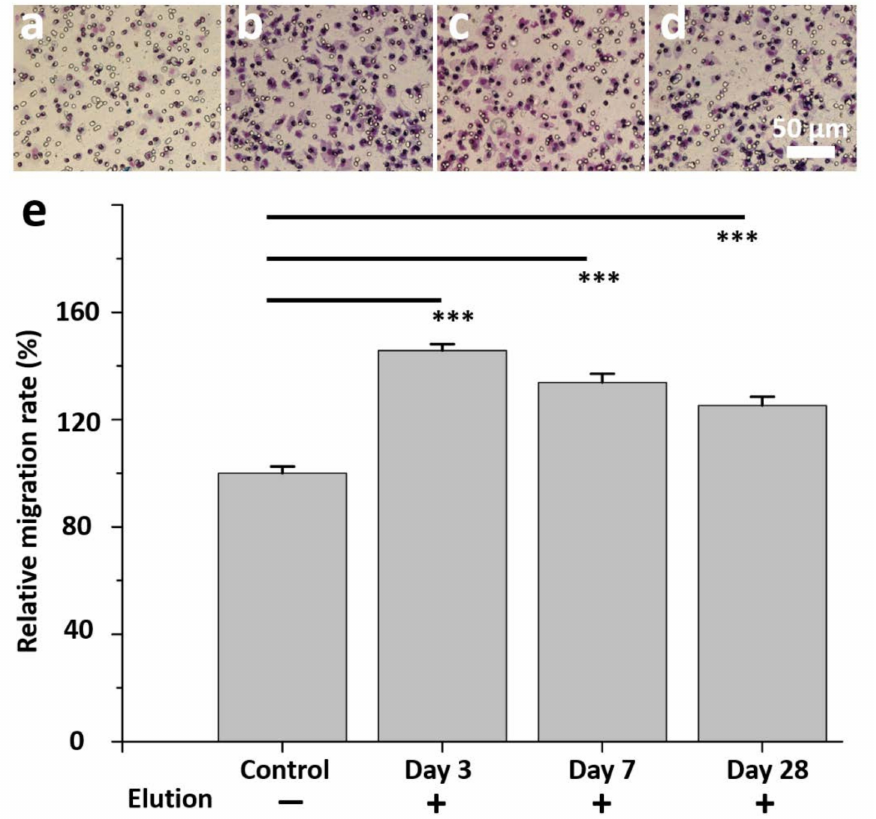
Figure 4. In vitro study of eluent of telmisartan/PLGA 756 scaffolds to test endothelial progenitor cells migration for two hours. ( a ) Control group without eluent. ( b ) EPCs with day 3 eluent. ( c ) EPCs with day 7 eluent. ( d ) EPCs with day 28 eluent. ( e ) Migration of cells in control group is significantly less than telmisartan/PLGA 756 scaffolds group. (*** p < 0.001). Figure 5 characterizes the re-endothelialization of damaged arterial walls. The surfaces of the struts were almost entirely covered with regularly shaped endothelial cells in close contact with each other (Figure 5a,b). However, poor alignment and extended irregular intercellular spaces were identified under higher magnification (200 × ) (Figure 5c,d). Ad- ditionally, significant intimal hyperplasia was observed in the control group (Figure 6e,f). The endothelia-dependent vasodilation in reaction to Ach (0.5 µ g/mL/min) was consider- ably better in the telmisartan-loaded stents (4.8 ± 2.2) than in the non-telmisartan-loaded ( − 1.9 ± 1.5) stents ( p = 0.002) (Figure 5g). After 28 days, endothelial coverage on the sur- faces of struts revealed that re-endothelialization was significantly greater in the telmisartan group (99.3 ± 0.1%) compared to the control group (95.3 ± 1.0%) ( p = 0.001) (Figure